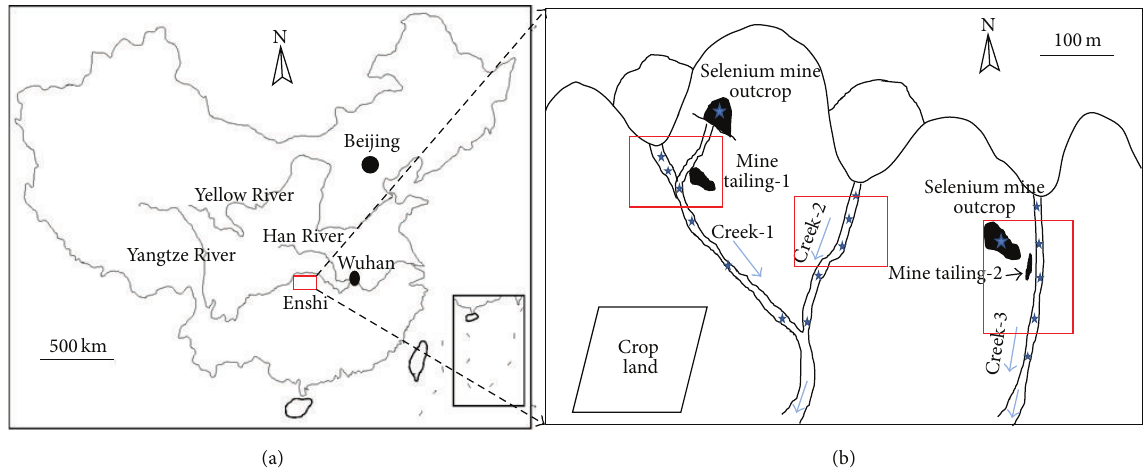
Figure 1: Study site and sampling: (a) the study area located in Enshi; (b) three sampling sites (red square) in selenium mine drainage areas.